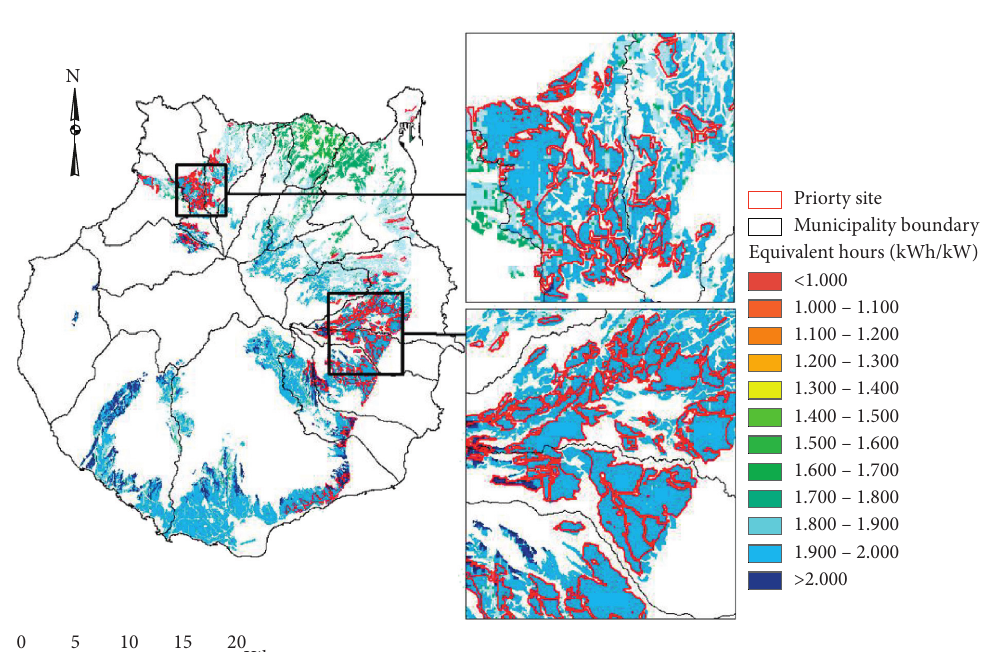
Figure 13: Solar equivalent